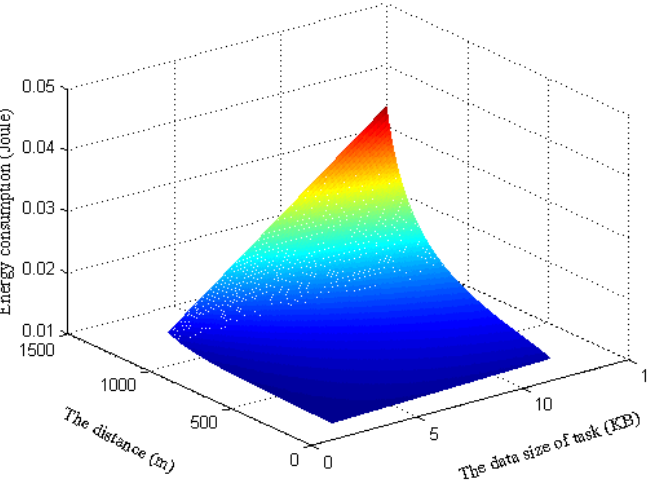
Figure 4. Energy consumption vs. different distances and data sizes of tasks.